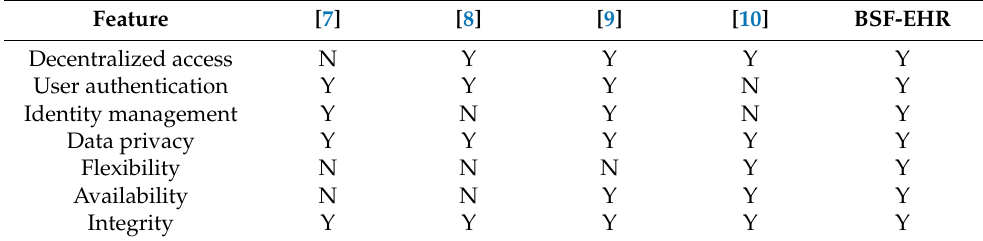
Table 1. Comparison of BSF-EHR with a few related